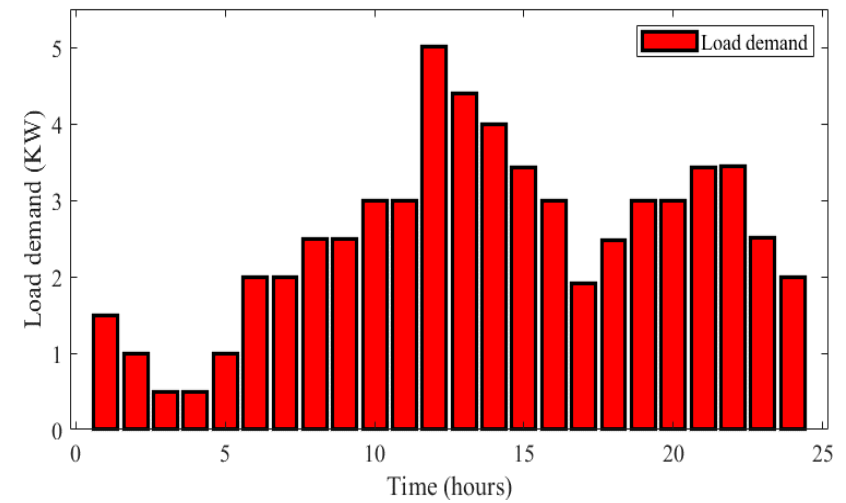
Figure 6. load demand of a typical house in remote area (KWh).